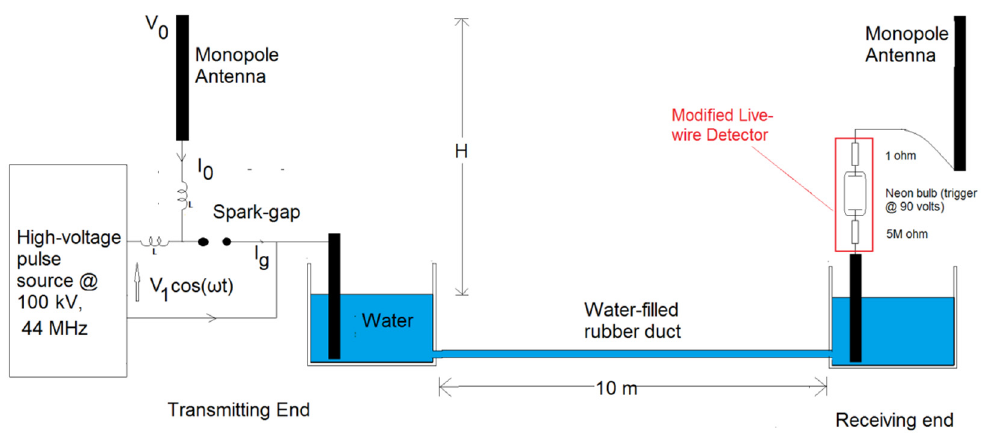
Figure 2. Experimental setup on wireless power transfer.